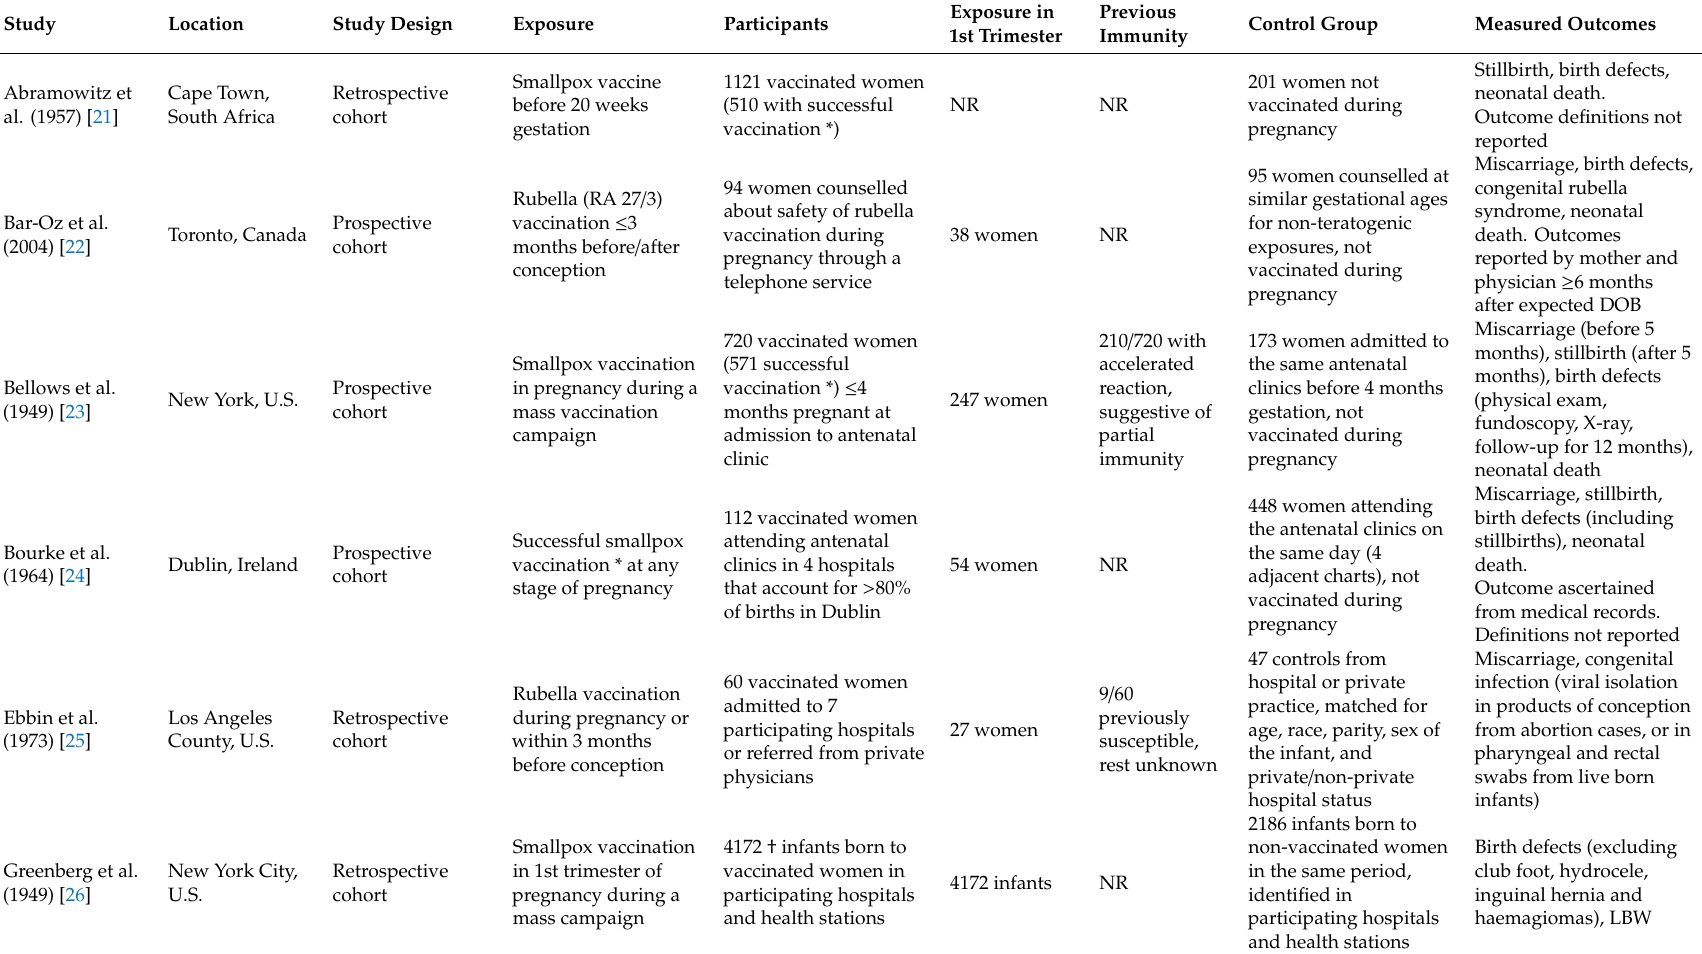
Table 1. Characteristics of included